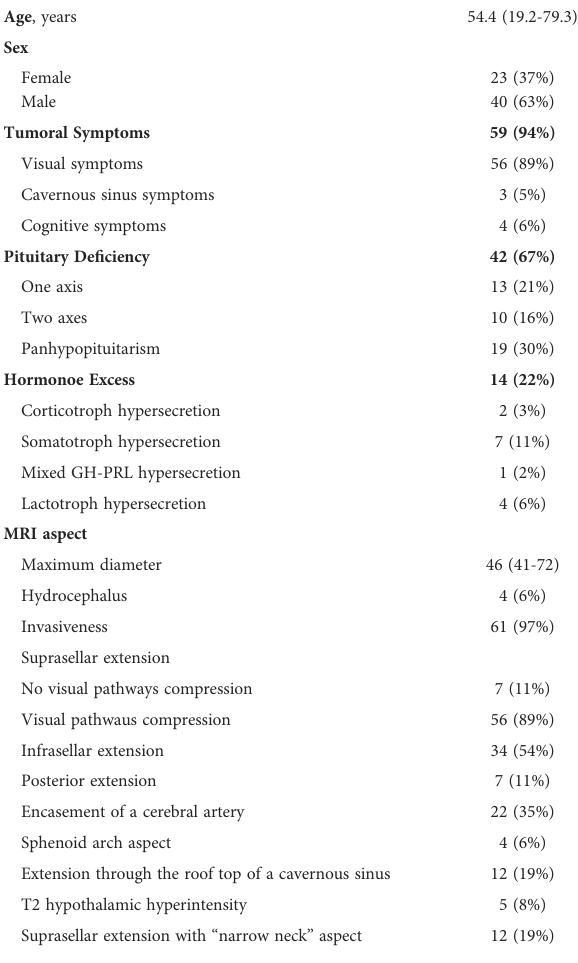
TABLE 1 Preoperative characteristics of 63 patients treated for a giant pituitary